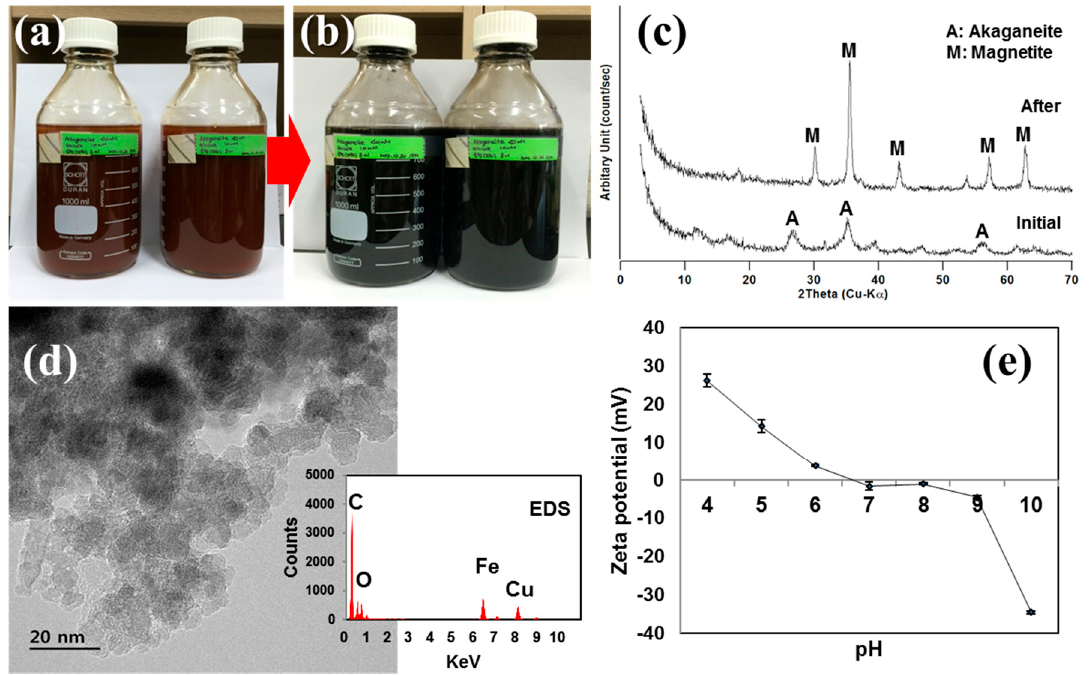
Figure 1. The colour changes due to phase transition of ( a ) brown akaganeite to ( b ) black magnetite, ( c ) XRD patterns showing mineral transformation, ( d ) TEM-EDS of biogenic magnetite nanoparticles, and ( e ) Zeta potential of BMNs.